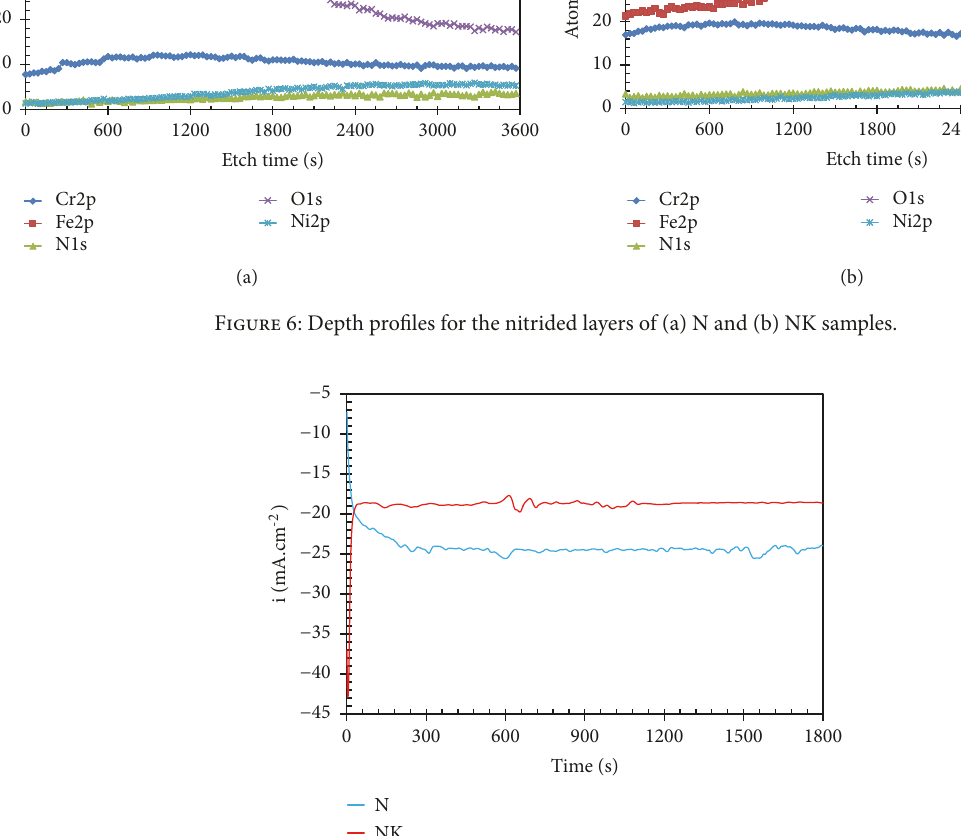
(less cathodic), indicating the electrochemical reactions are more intense when the samples are treated in this